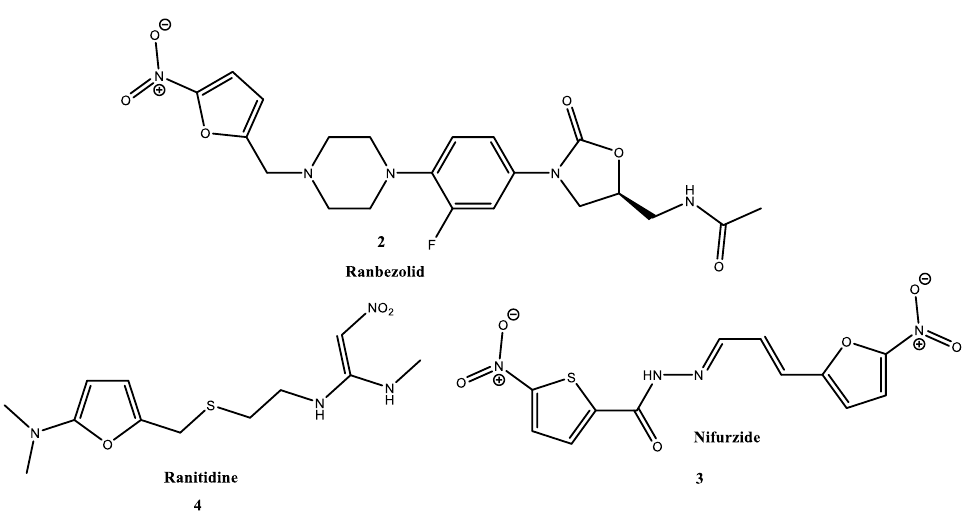
Figure 1. Structural formula of nitrofurantoin 1 .